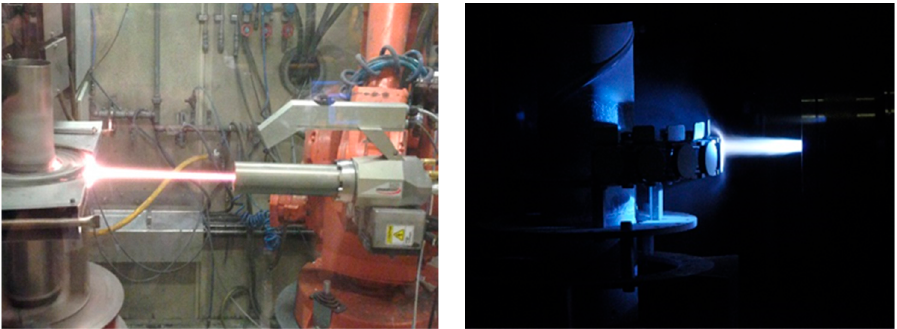
Figure 1. Emergent thermal spray techniques of ( left ) high velocity air-fuel (HVAF) and ( right ) suspension plasma spraying.